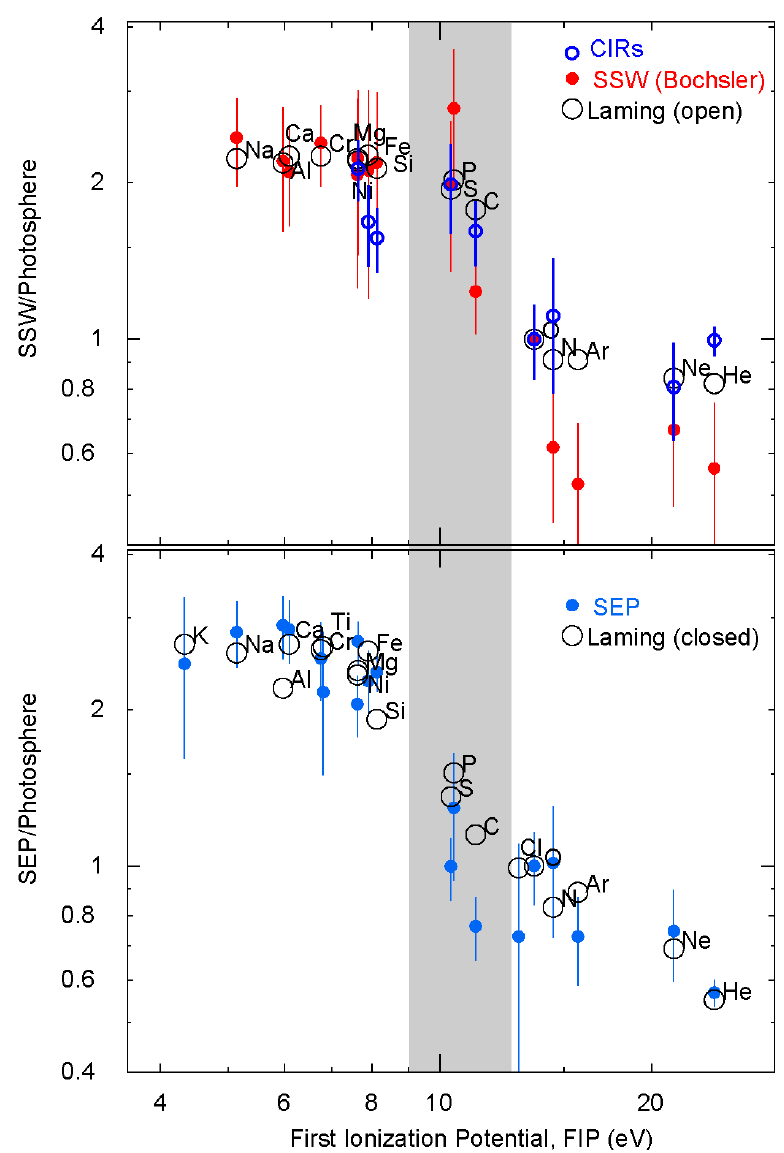
Figure 9. The lower panel compares the FIP pattern of SEPs [59] with the closed loop model of Laming [87] (Table 3). The upper panel compares the SSW [85] and corotating interacting region (CIR) [59] FIP patterns the open field model of Laming [87] (Table 4) [59]. The gray band highlights the region of di ff erences of C, P, and S between the two populations